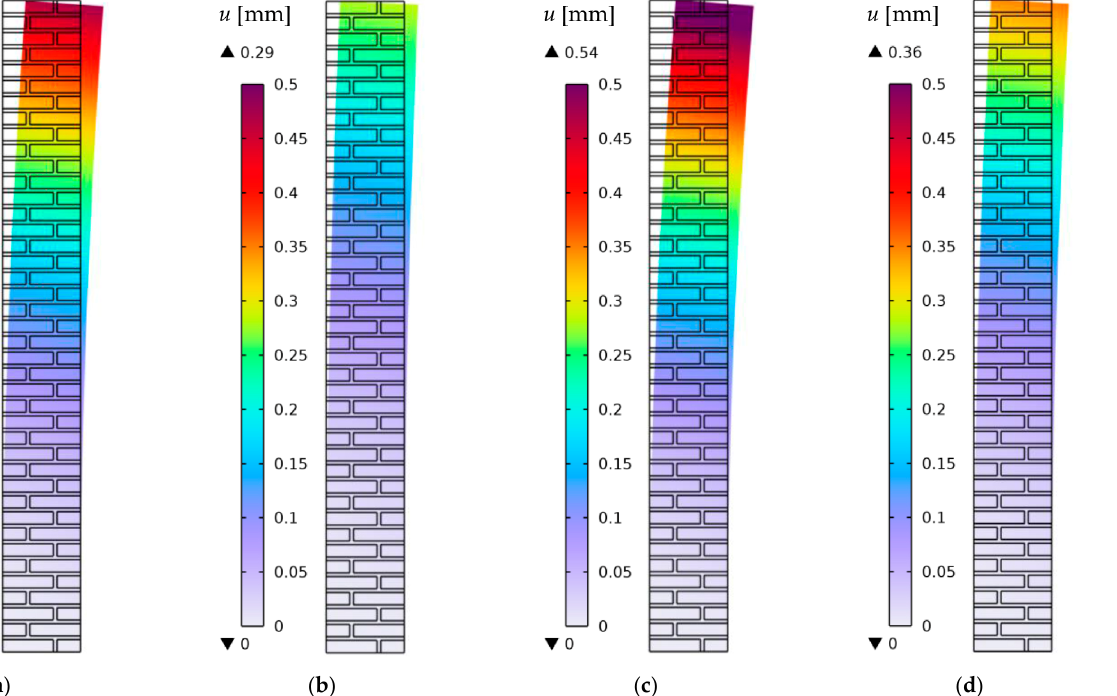
Figure 16. Hygro-thermo-mechanical analysis of the studied three-wythe brick masonry wall: max- imum displacement obtained for the wall with natural hydraulic lime mortar assuming initial con- ditions equal to ( a ) external conditions and ( b ) internal conditions; maximum displacement for the wall with cement mortar assuming initial conditions equal to ( c ) external conditions and ( d ) internal conditions.